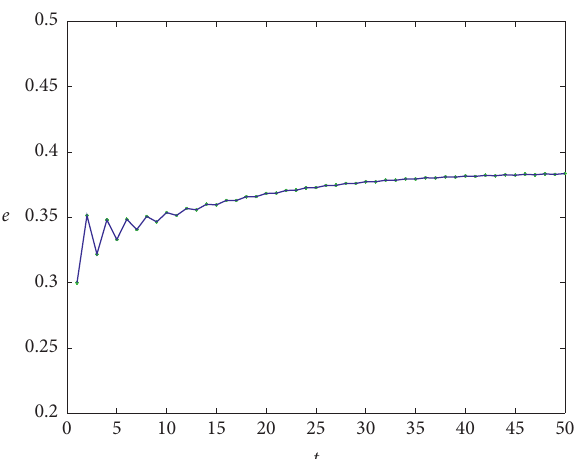
Figure 14: The production quantity fluctuations of the manufacturer.